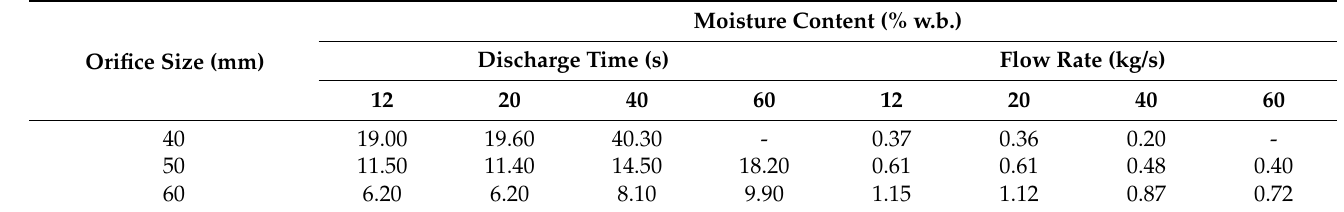
Table 3. Discharge times and flow rates of soybeans with various moisture content at different orifice sizes.